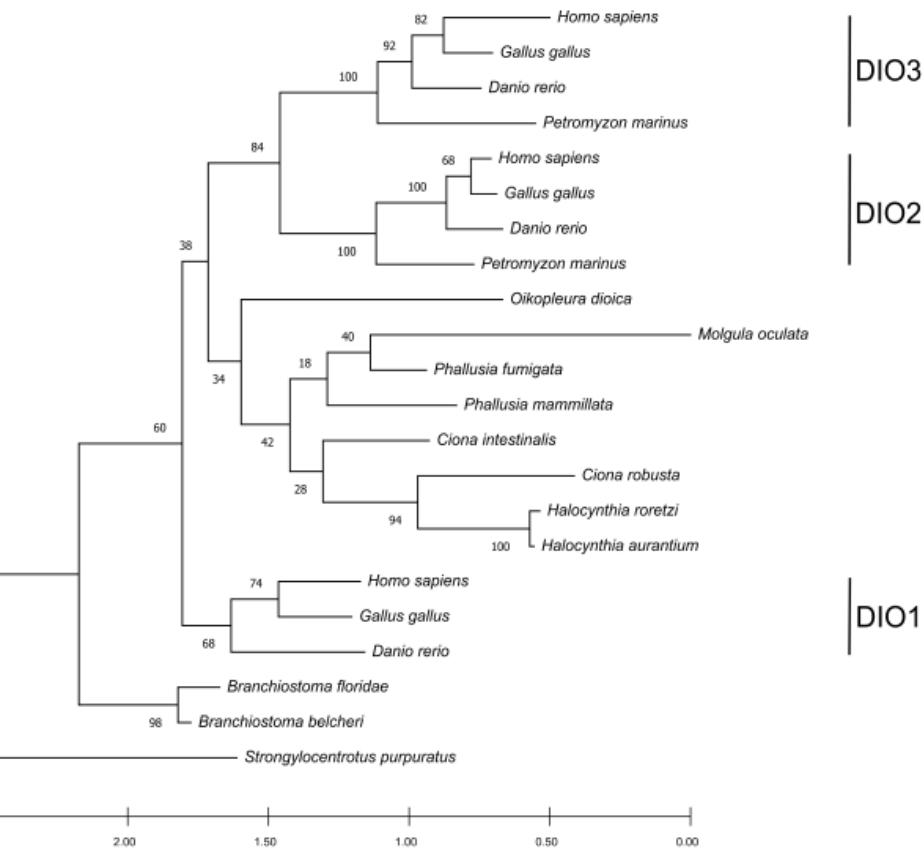
Figure 4. The phylogenetic tree inferred using DIO amino acid sequences (22 sequences aligned on 274 positions). The tree was built via the maximum likelihood method using the JTT model for aminoacidic substitution as implemented in the software MEGAX [28]. The tree with the best log likelihood ( − 7865.03) is shown. The bootstrap support is shown on each node. The scale at the bottom is the substitution per site, a standard measure of tree branch